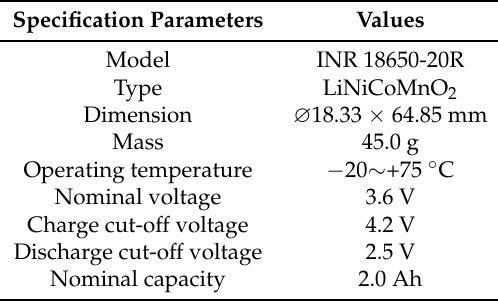
Table 2. Tested battery.